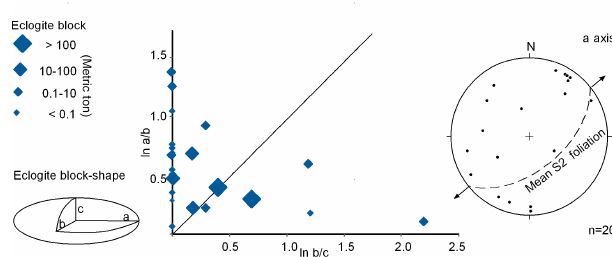
Figure 13. The shapes of the eclogite pods show a range of ge- ometries in a Flinn diagram from prolate to oblate. The size of the symbols is proportional to size of the